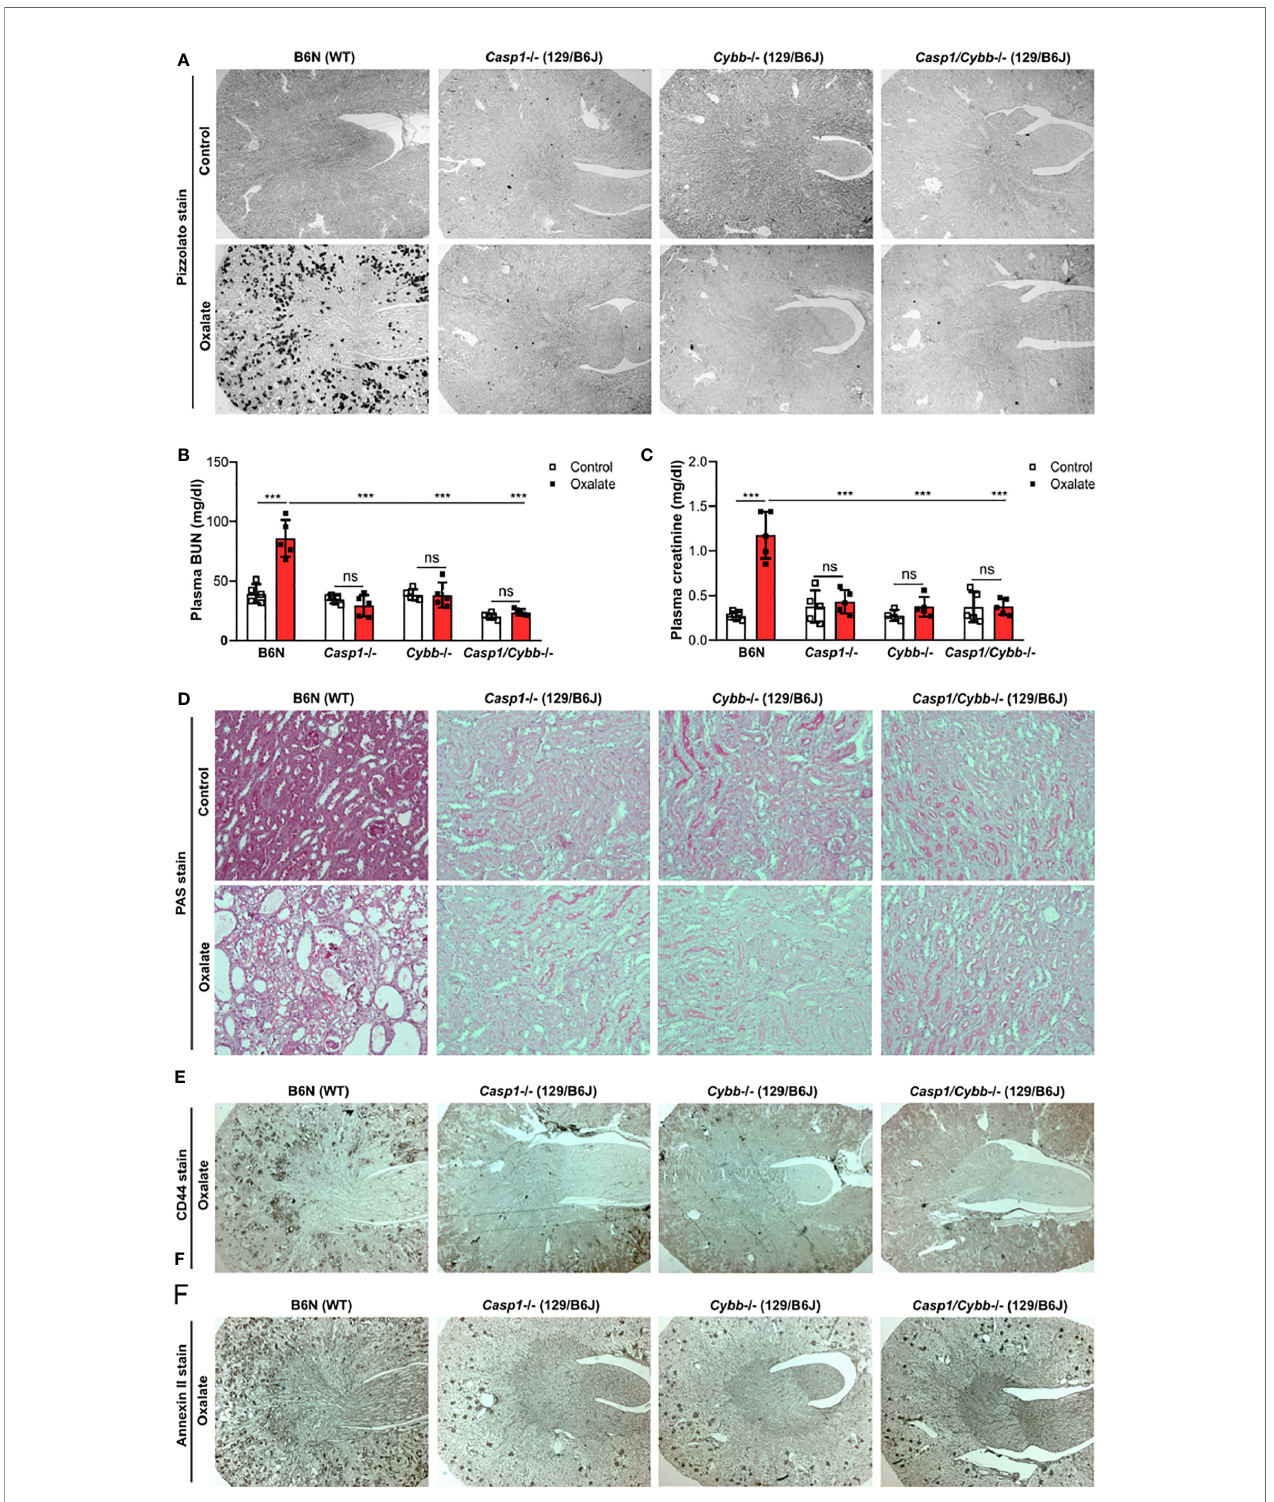
FIGURE 1 | Knockout mice on a 129/B6J background do not develop CaOx-related nephrocalcinosis. C57BL/6N WT (B6N) and Casp1 -, Cybb -, Casp1/Cybb - de fi cient (129/B6J background) mice were either fed a control diet or an oxalate-rich diet for 14 days. (A) Pizzolato staining to identify CaOx crystal deposits in kidney sections of all four mouse strains. (B, C) Plasma BUN (B) and plasma creatinine (C) levels were measured using colorimetric assays. (D) PAS stain illustrates tubular injury. Original magni fi cation x200. (E, F) Immunostaining of the adhesion molecules CD44 (E) and annexin II (F) in kidney sections. Original magni fi cation ×25. Data are mean ± SD from 4 to 5 mice per group. ***p < 0.001; ns, not signi fi cant by two-way